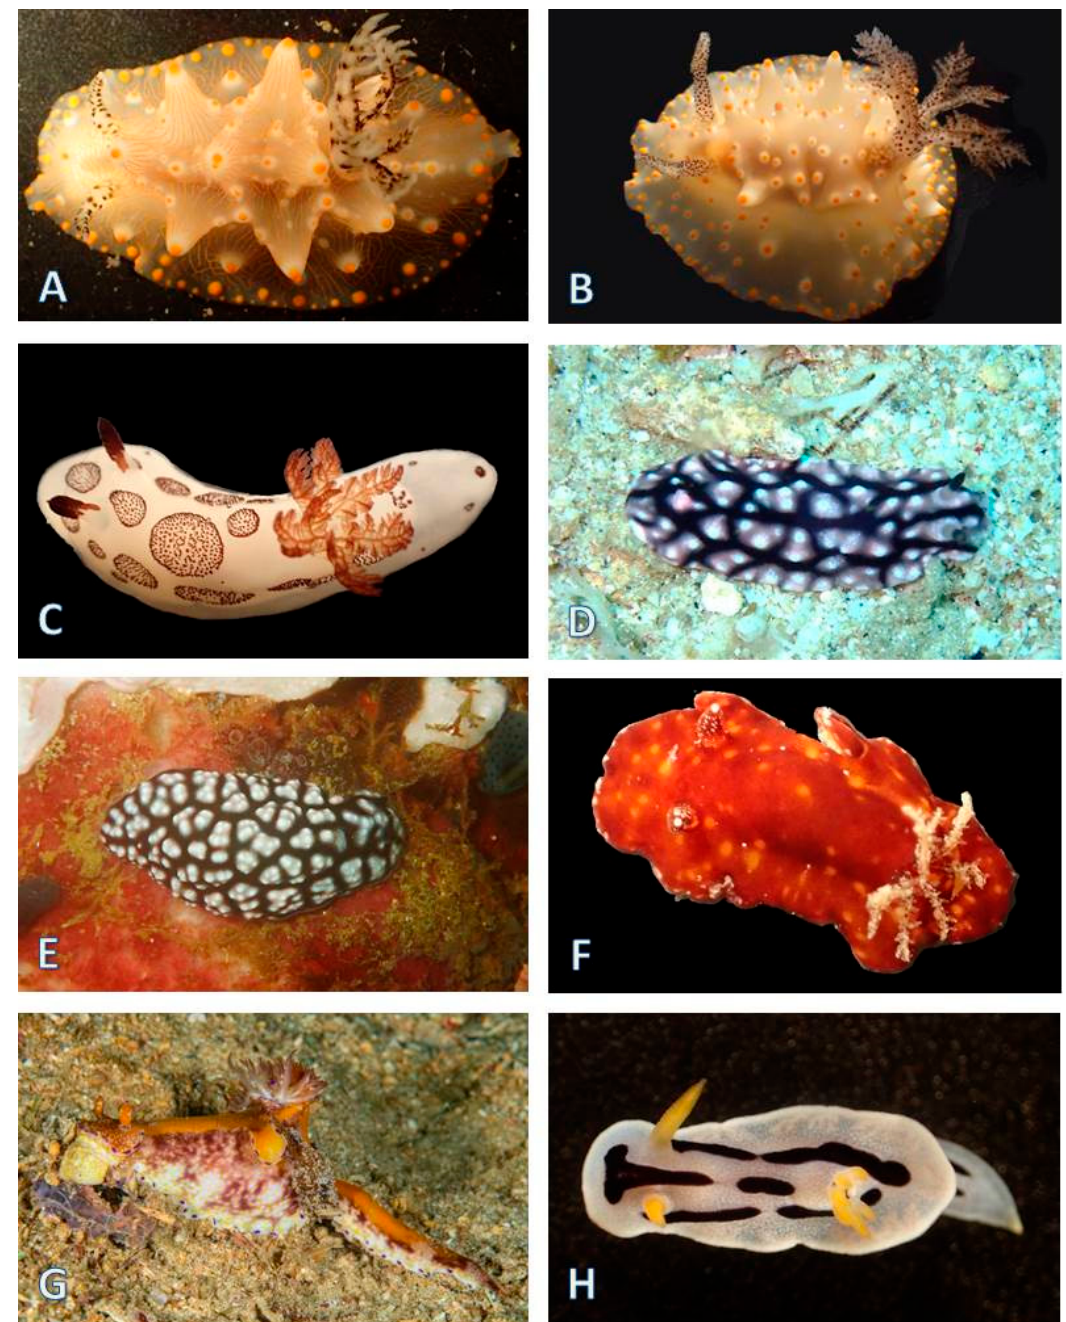
Figure 10. Nudibranchia Doridina: ( A ) Halgerda batangas , Haba18Ba-8; ( B ) Halgerda carlsoni , Haca17Ba-2; ( C ) Jorunna funebris , Jofu17Ba-1; ( D ) Paradoris liturata in situ, Phpu17Ba-6; ( E ) Phyllidiella pustulosa mimicked by Paradoris liturata ; ( F ) Platydoris sanguinea , Plsa17Ba-1; ( G ) Ceratosoma tenue *; ( H ) Chromodoris dianae , Chdi18Ba-1. *Specimen not collected.